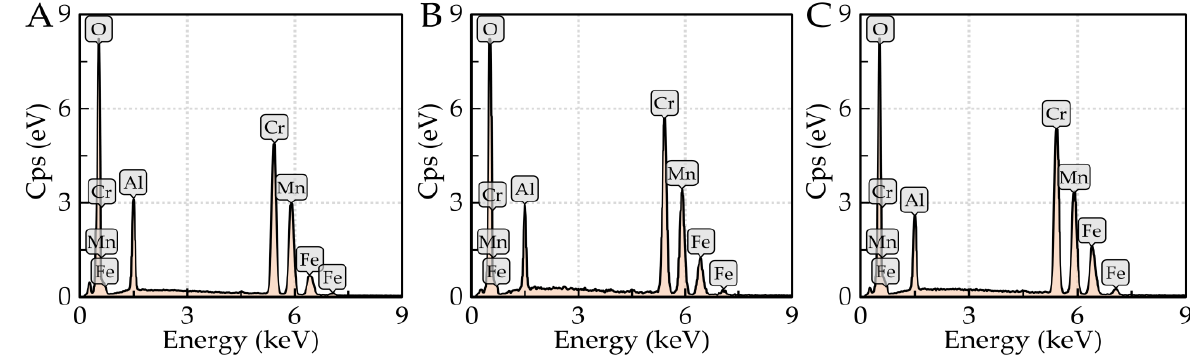
Figure 6. EDX spectra collected from spot microanalysis of sample 7; ( A – C ) correspond to spectra 1, 2, and 3.